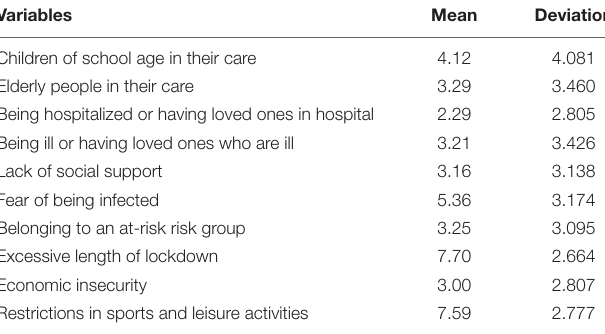
TABLE 3 | Impact on teachers’ daily